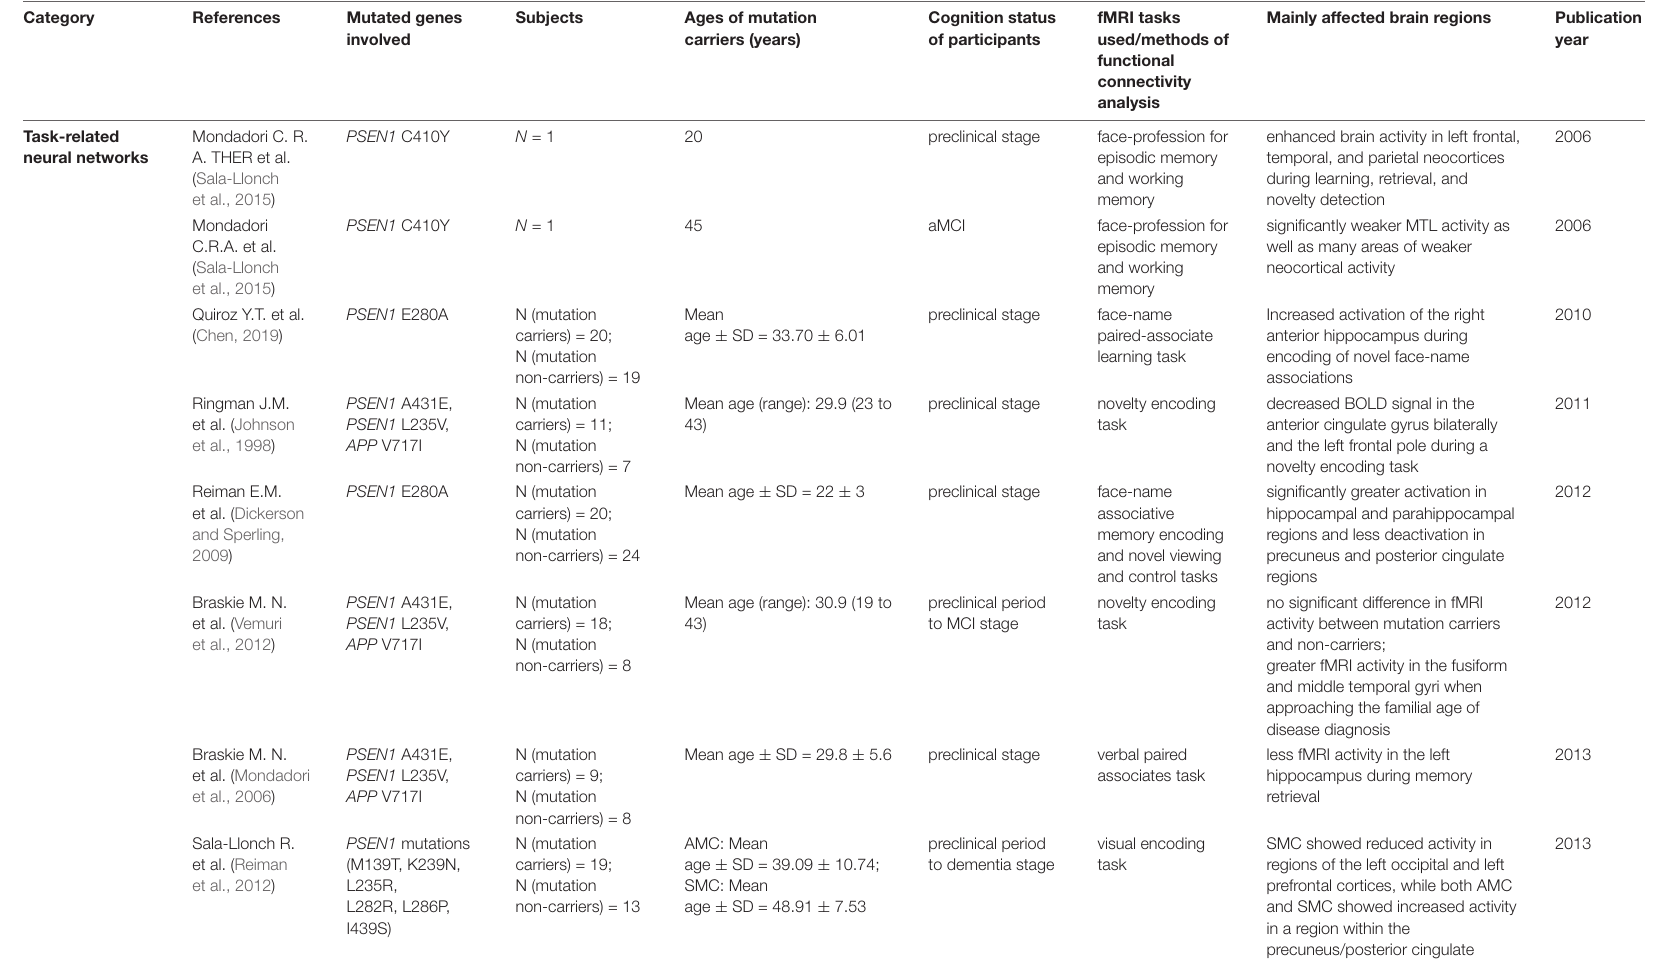
TABLE 1 | Characteristics of studies investigating functional magnetic resonance imaging (fMRI) changes in autosomal dominant Alzheimer’s disease